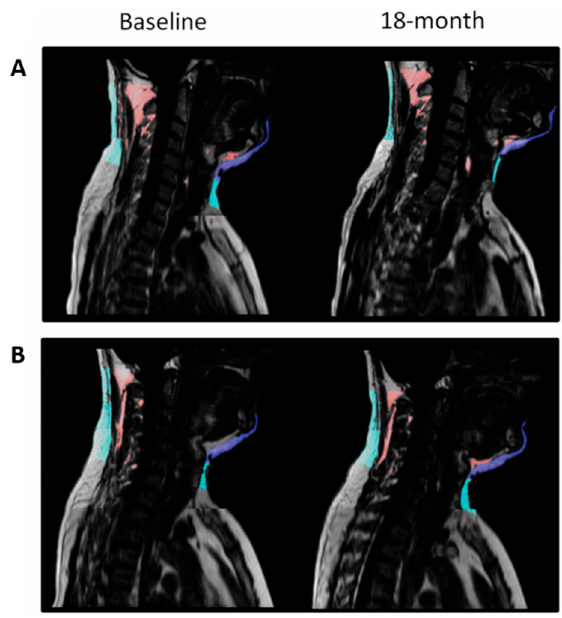
Figure 4. MRI of cervical-SAT—comparison between two matched participants with different weight loss achievements. Panel ( A ) and ( B ) demonstrate the sagittal section of subjects A and B, respectively. Cervical-SAT was divided into color-coded compartments: light blue, cervical-SAT; dark blue, chin-SAT; and red, non-classified fat- fat beneath the fascia. Both men had a baseline weight of 83 kg and waist circumference of 105 cm; following the 18-month intervention, participant A lost 18 kg, and participant B gained 5.4 kg. The two men differed distinctly in their 18-month cervical-SAT ( − 51.97% vs. +2.52%) and chin-SAT ( − 27.5% vs. +4.82%) reductions.